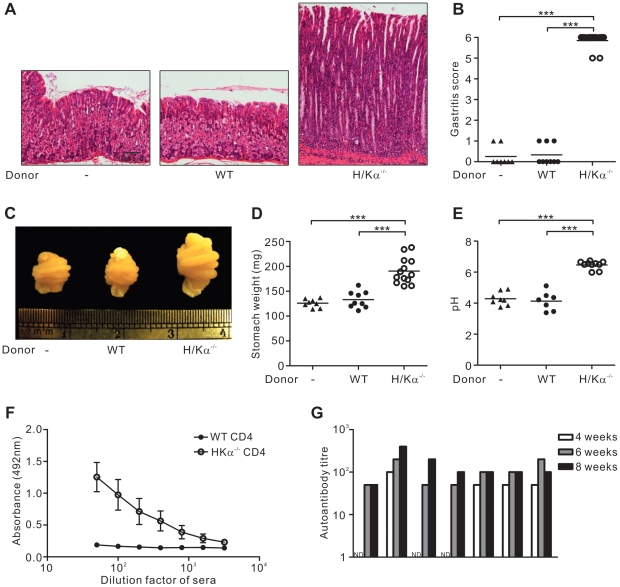
Mice that receive CD4+ T cells from H/Kα−/− mice develop severe autoimmune gastritis.Irradiated wildtype mice that received 5×107 CD4+ T cells from either wildtype (WT) or H/Kα−/− mice, were killed 8 weeks after transfer and compared to non-manipulated mice (−). (A) Haematoxylin and eosin stained sections of stomachs (B) Gastritis scores. (C) Macroscopic views of stomachs (D) Stomach weights after stomach contents were removed (E) Gastric pH. Mice were starved overnight and their stomachs were rinsed in 1 ml saline which was then collected and measured by a pH meter. (F) H+/K+ ATPase-specific autoantibodies in serum were detected by ELISA using serial 2-fold dilutions of mouse sera, with a starting dilution factor of 50. Error bars, standard error. (G) Gastric H+/K+ ATPase autoantibody levels in mice at various times after cell transfer. Serum samples were collected at the indicated time points from each mouse after transfer of CD4+ T cells from H/Kα−/− mice. Autoantibody titre was represented by the maximum dilution factor that had an absorbance reading above 50% maximum. ND = not detectable. Data pooled from four independent experiments. In (B), (D) and (E), each circle represents the data from one mouse. Mann-Whitney U test was used; bars, mean and ***, P<0.001.